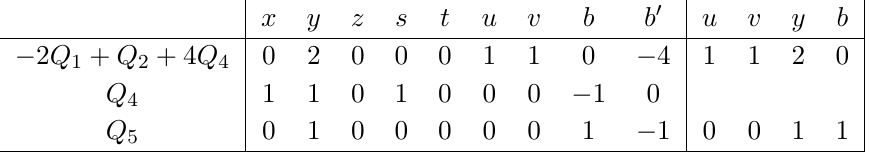
Table 8 . ( C (cid:3) ) actions on exceptional locus b 0 = 0 at b 6 =